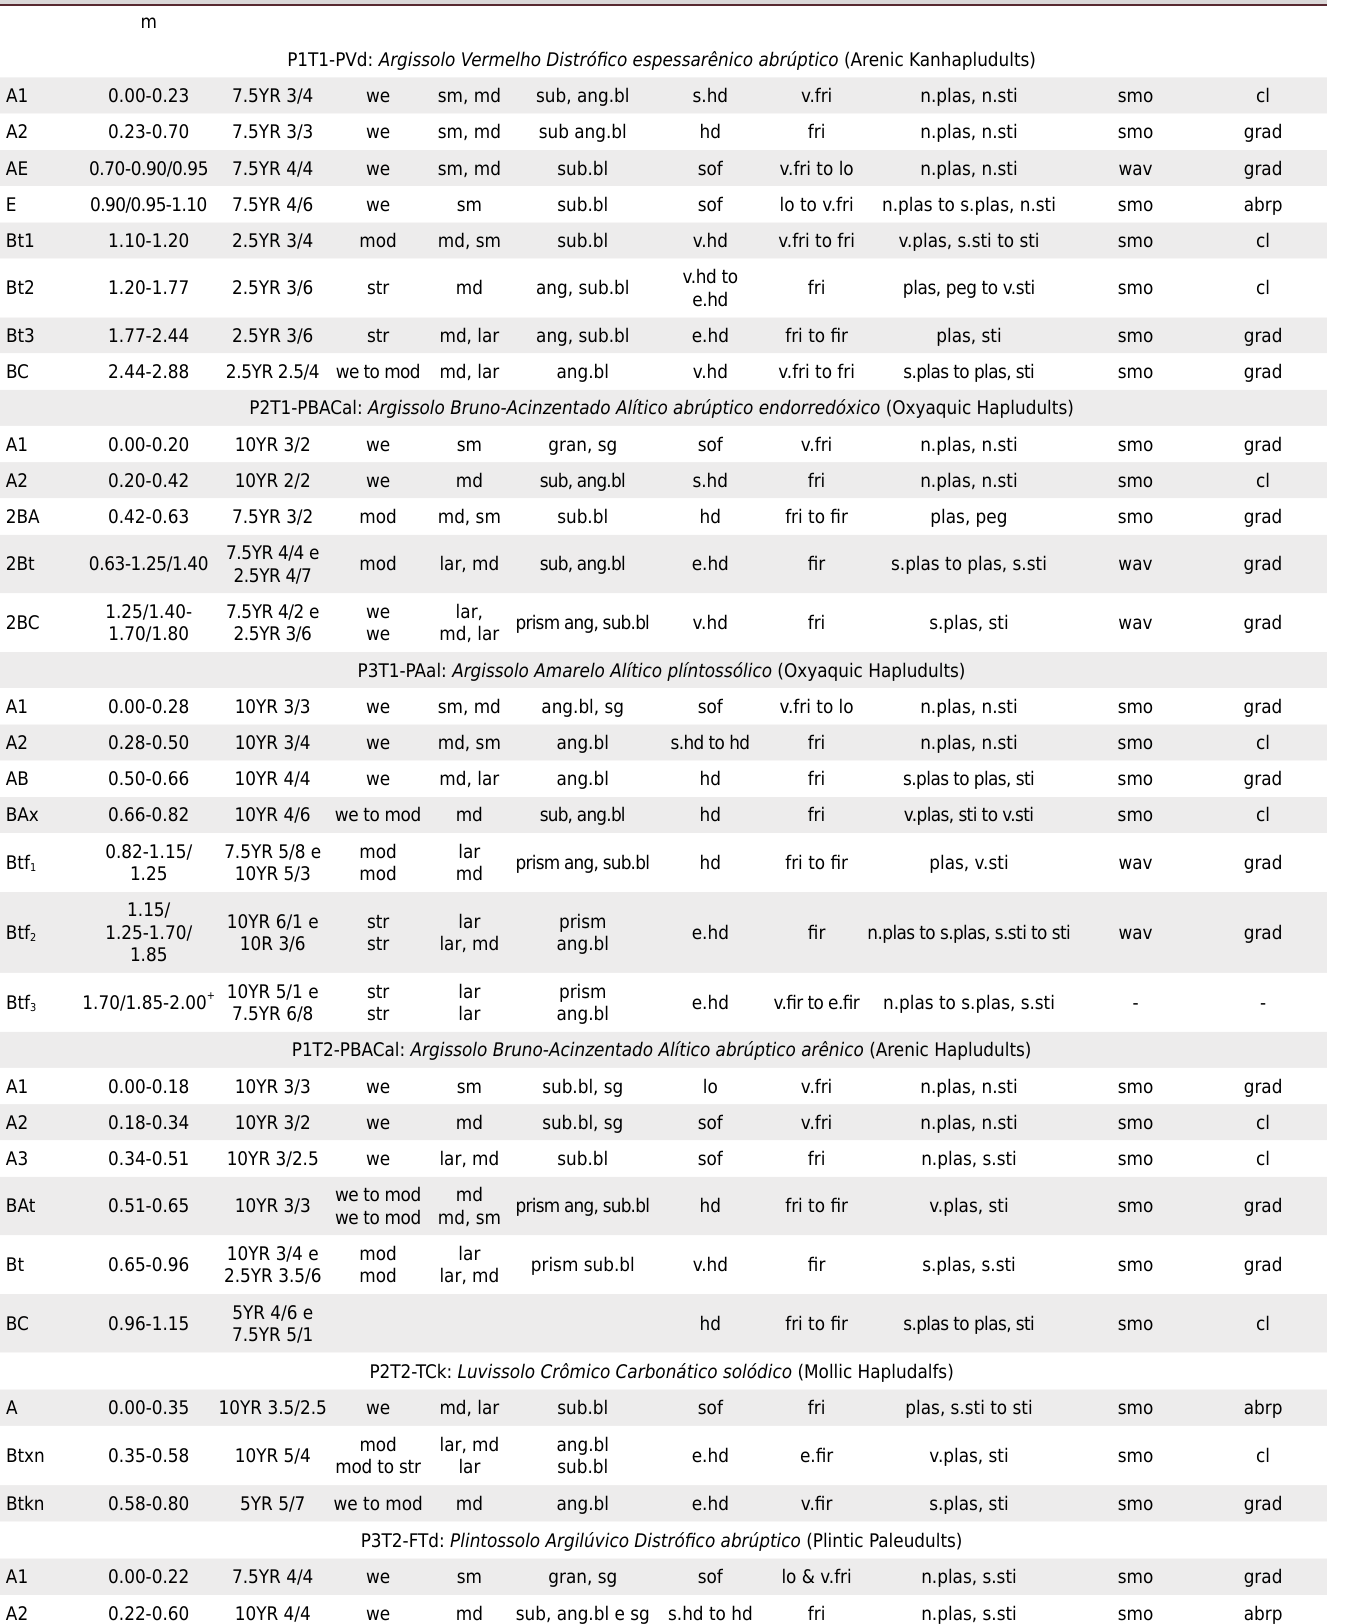
Table 1. Morphological characterization of the soil in horizons A and B of the studied profiles Horizon